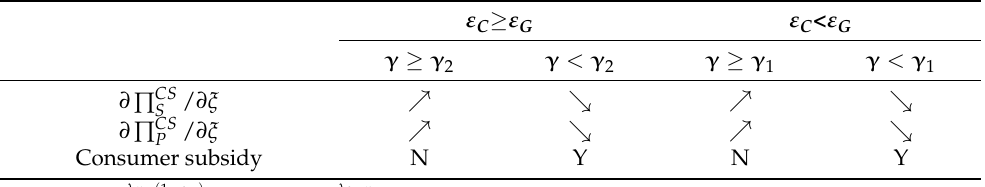
Table 3. Consumption subsidy